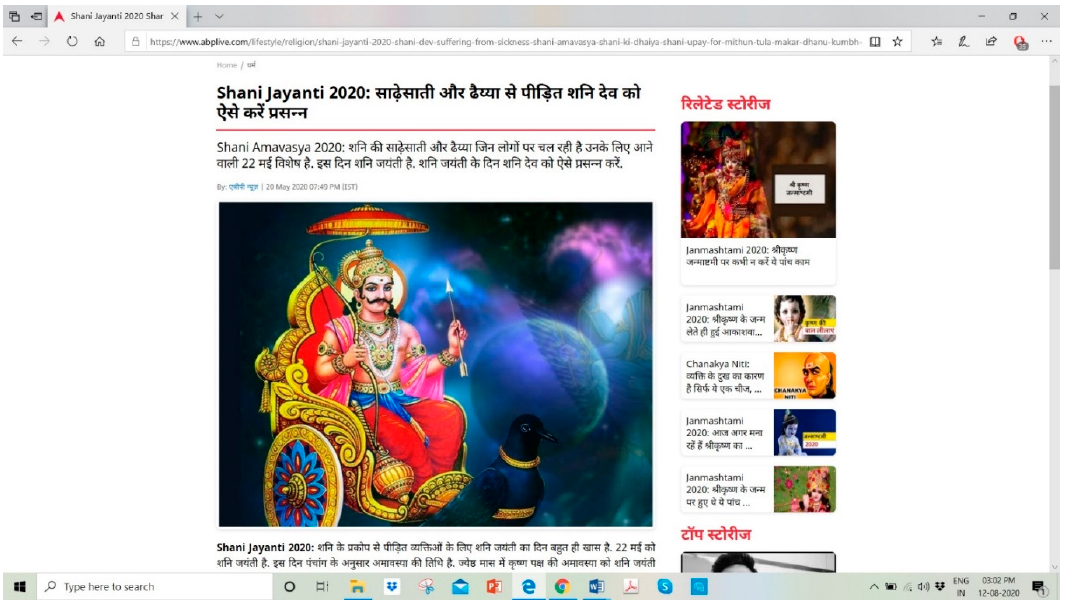
Figure 6. Shani with a pastoral background. Source: Times Now Digital.